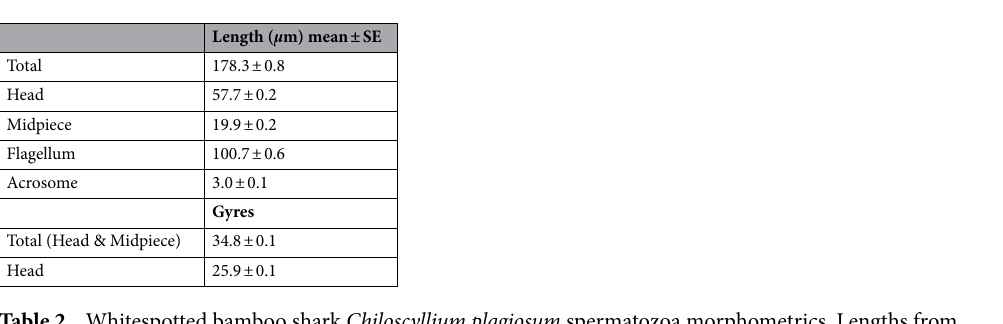
Table 2. Whitespotted bamboo shark Chiloscyllium plagiosum spermatozoa morphometrics. Lengths from digital image analysis of 10 spermatozoa per shark from five sharks were measured and summarized as a mean and standard error